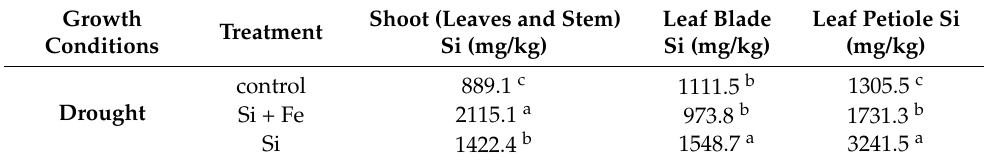
Table 3. Silicon content in oilseed rape plants under drought.